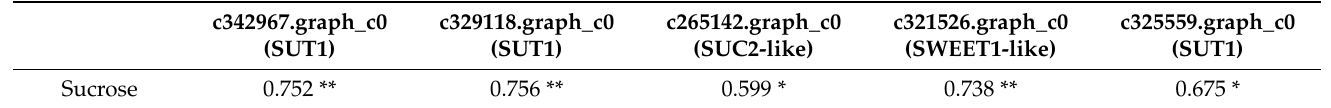
Table 1. Correlation analysis between gene expression and sucrose